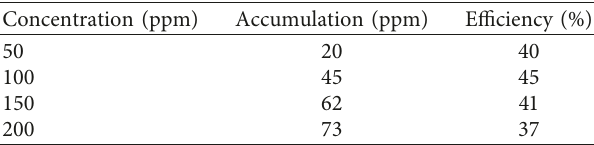
Table 3: Accumulation of Cu 2+ by peanut peels.